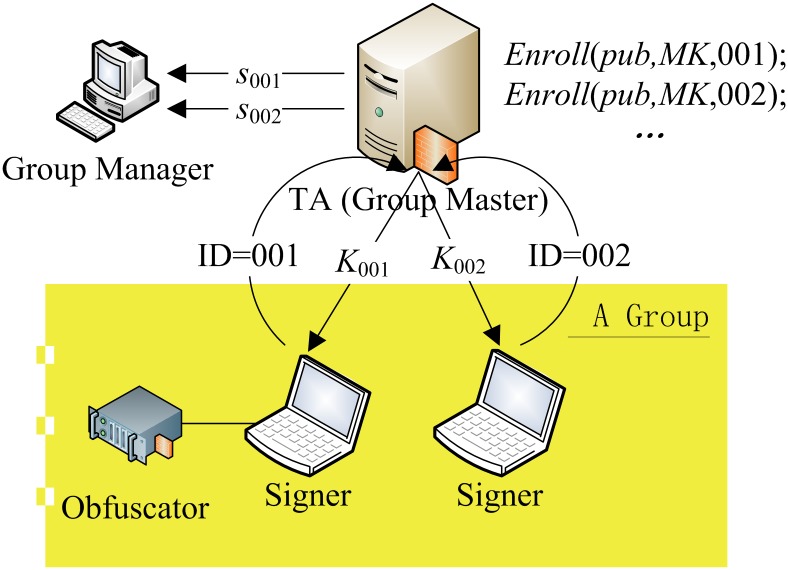
The usage of the Enroll algorithm.